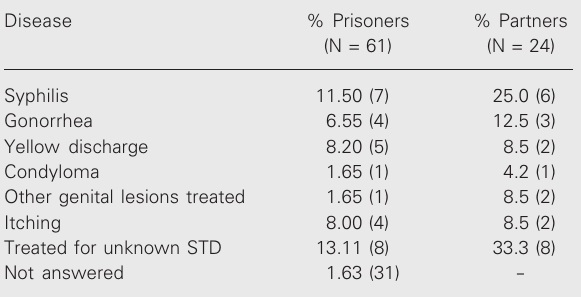
Table 5. History of past and present sexually transmitted diseases (STD) reported by the prisoners in the Butantã Women’s Peniten- tiary, Sao Paulo, Brazil, and their knowledge of their partners having STD.